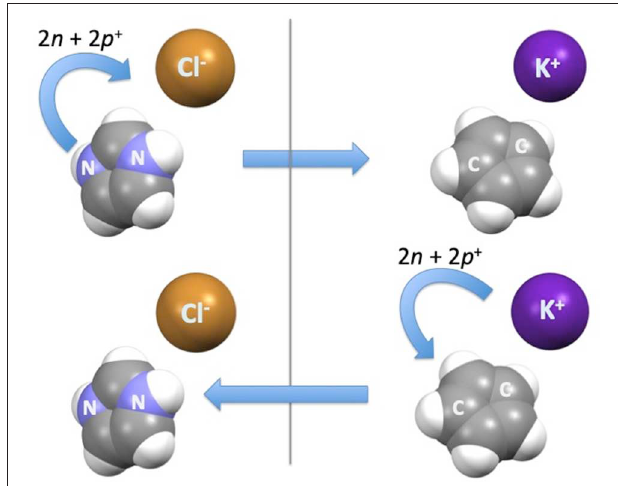
FIGURE 12 | The conceptual transfer of two neutrons and two protons to obtain charge-inverted ionic pairs—the 1-alkyl-3-methylimidazolium chloride and its isoelectronic and isostructural counterpart, the potassium 1-alkyl-3-methylcyclopentadienyl.